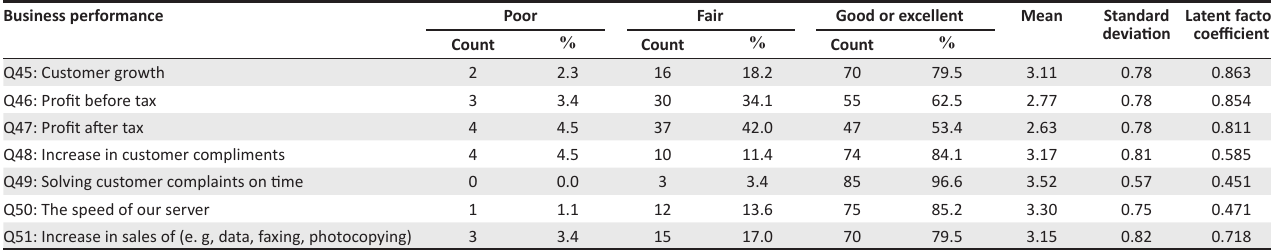
TABLE 7: Descriptive statistics for the construct of business performance. Business performance Poor Fair Good or excellent Mean Standard